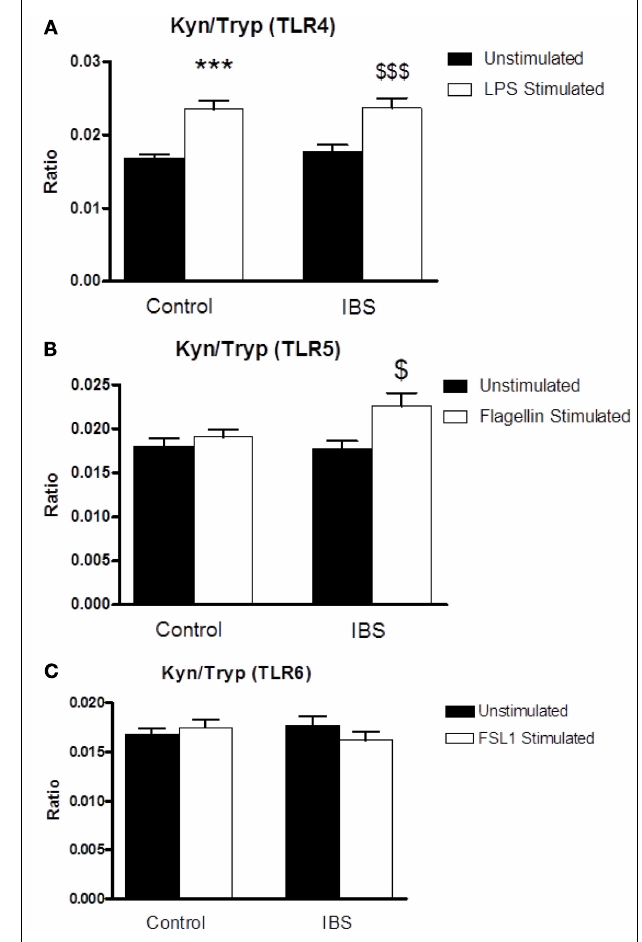
FIGURE 3 | Kynurenine:tryptophan (Kyn:Tryp) ratio in unstimulated whole blood supernatants from healthy controls and IBS patients and following stimulation with: (A)TLR4 agonist LPS, (B)TLR5 agonist flagellin, and (C)TLR6/1 agonist FSL1. Data are expressed as mean ± SEM. Statistical differences between treatments and disease states were determined using two-way ANOVA with Bonferroni post hoc test. *** p < 0.001, Healthy control stimulated vs. unstimulated; $ p < 0.05, IBS stimulated vs. unstimulated; $$$ p < 0.001, IBS stimulated vs. unstimulated.There was no significant interaction between disease state and treatment following stimulation with theTL6/2 agonist FSL1 ( F 1,124 = 1.026, p = 0.313) not was there any alteration in the kynurenine:tryptophan ratio in either healthy controls or IBS subjects ( Figure 3C